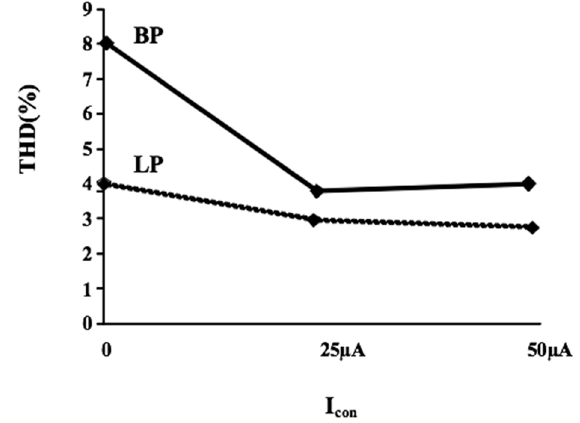
Figure 9. The simulated THD for LP and BP outputs.